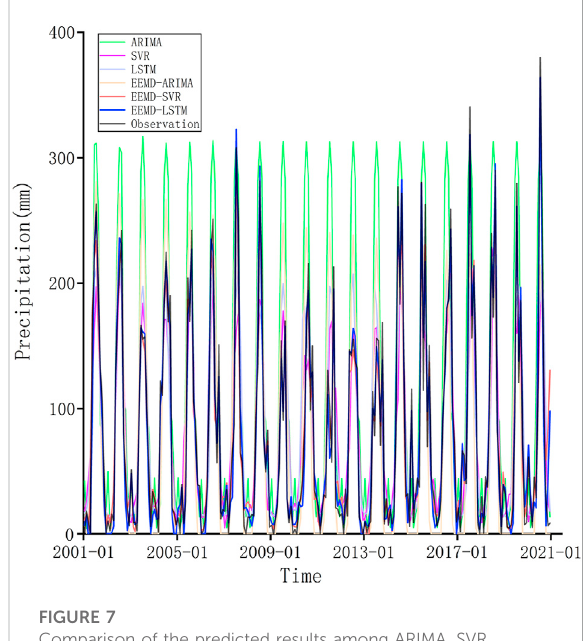
FIGURE 7 Comparison of the predicted results among ARIMA, SVR, LSTM, EEMD-ARIMA, EEMD-SVR, and EEMD-LSTM.